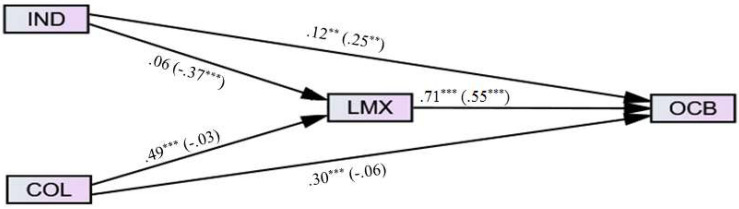
Path diagram for male group (n = 114) and female group (n = 131; in parenthesis), study 1. *p < 0.05, **p < 0.01, ***p < 0.001. χ2(df) = 22.77 (2), p = 0.433, χ2/df = 11.38, SRMR = 0.02, CFI = 0.93, GFI = 0.96, NFI = 0.93, ECVI = 0.24, RMSEA (90% CI) = 0.20 (0.13–0.28), p-close = 0.000.